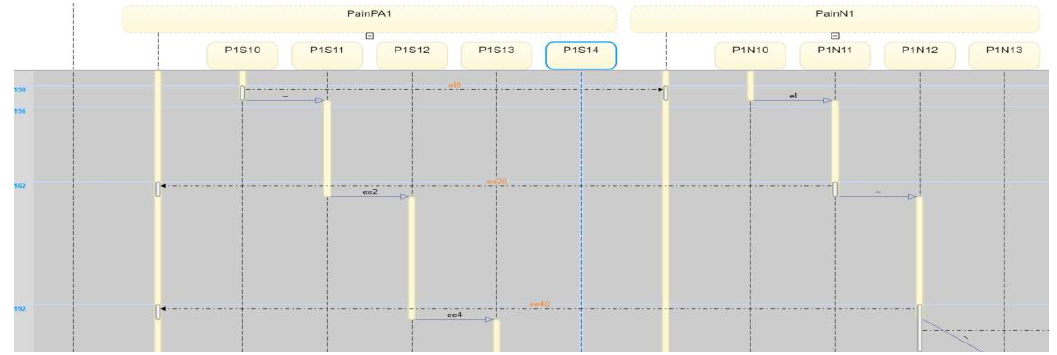
Figure 20. Dynamics of the hospitalist, H 1 , in terms of developing a care plan for the intervention to avoid the pain symptom. Sensors 2018 , 18 , 2531 20 of 29